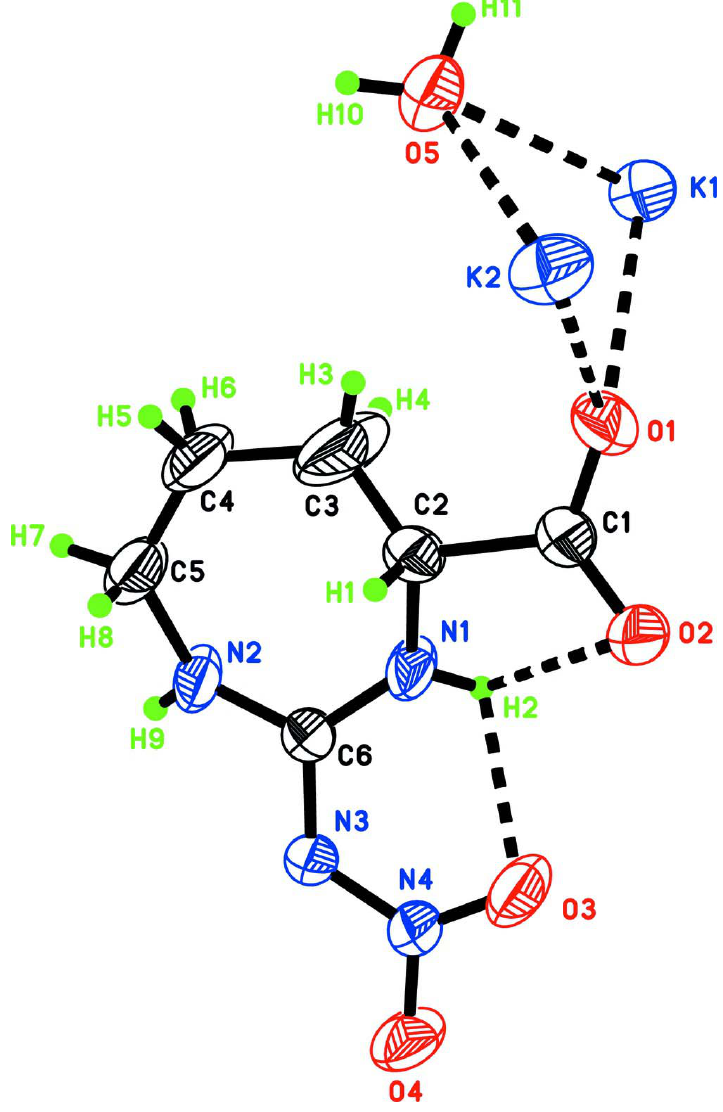
Figure 1 A perspective view of the asymmetric unit, showing the atomic numbering and displacement ellipsoids drawn at the 50% probability